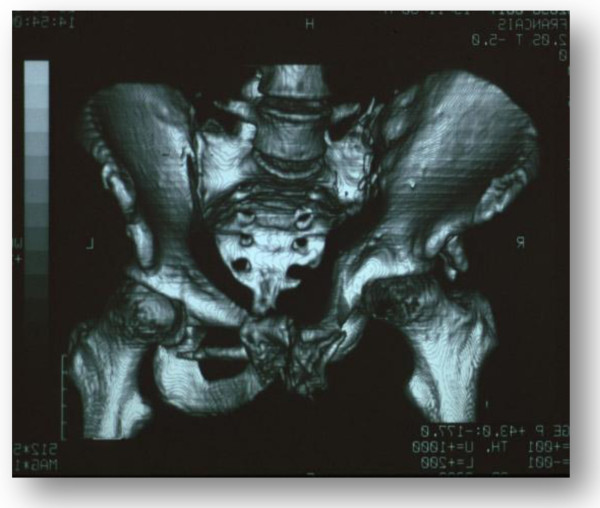
Acetabular fracture.